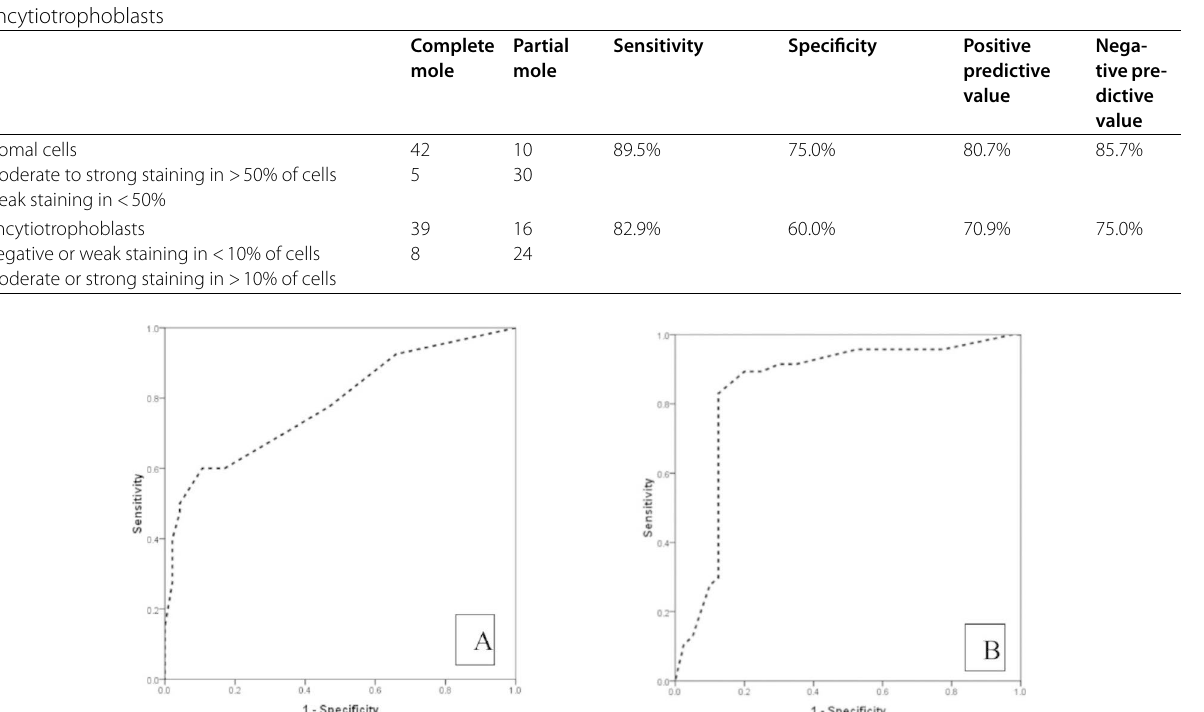
Fig. 2 The ROC curve analysis in determining the value of percentage of Twist-1 expression in syncytiotrophoblasts (A) and CS (B) for the distinction of complete from partial molar pregnancy